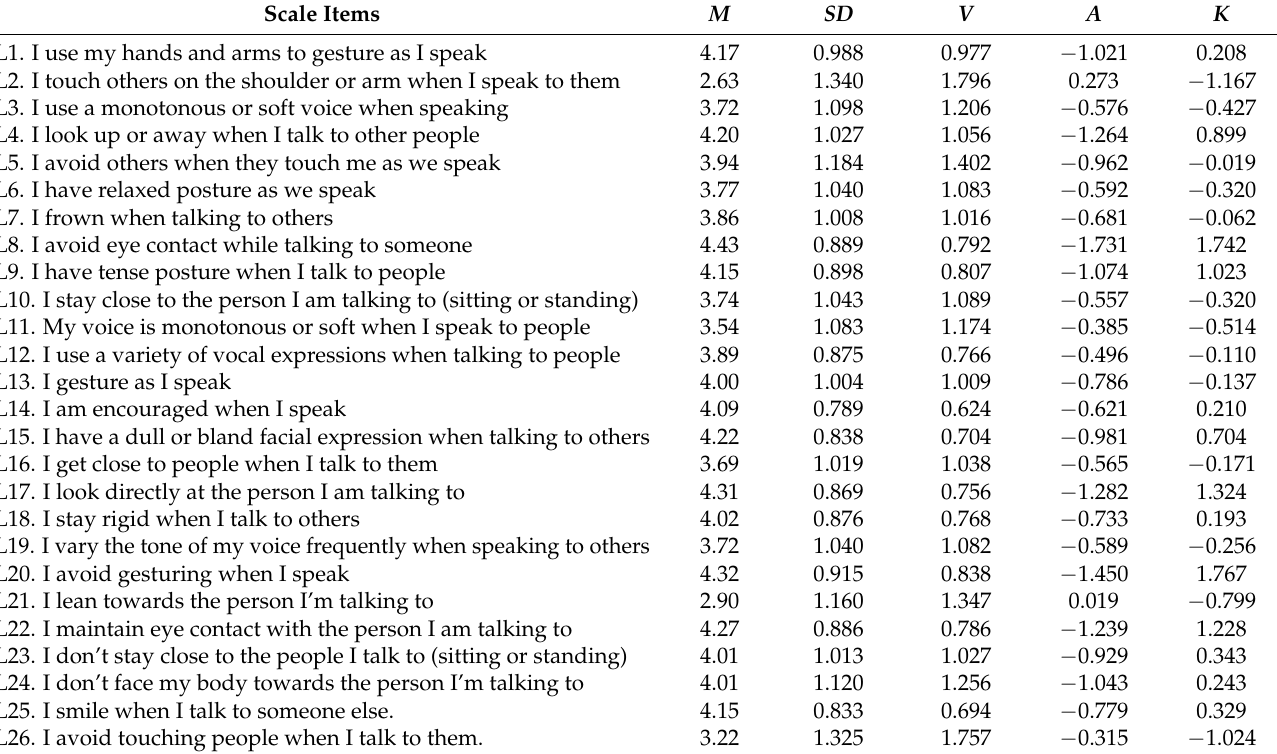
Table 1. Descriptives of the Non-Verbal Immediacy